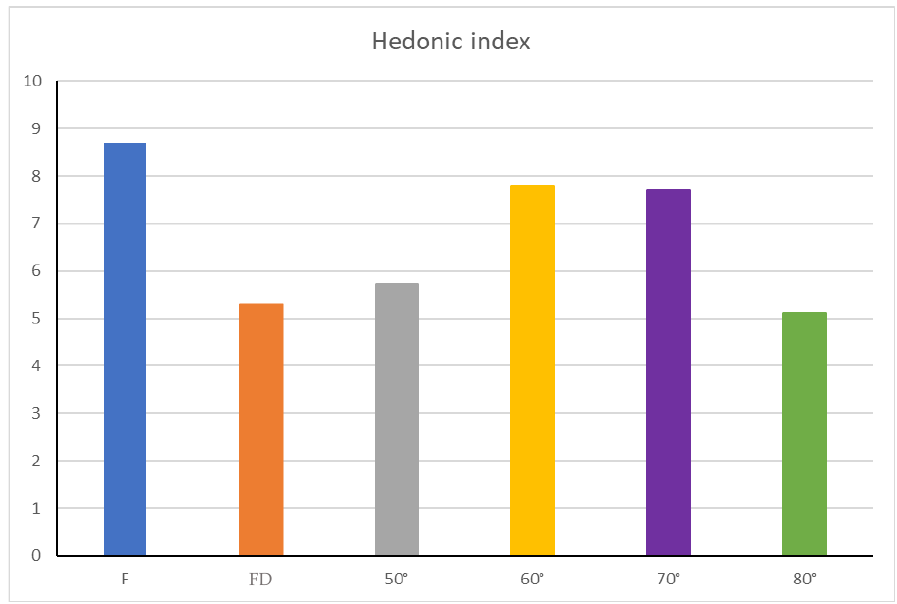
Figure 4. Overall hedonic indices of dried flowers. Abbreviation: F—fresh flowers; FD—freeze-dried.